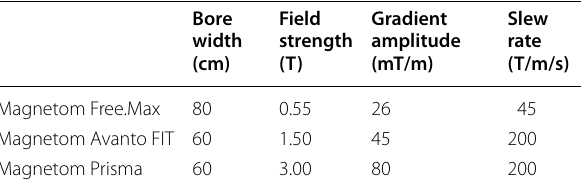
Table 1 Specifications of 0.55‑T, 1.5‑T, and 3‑T scanner